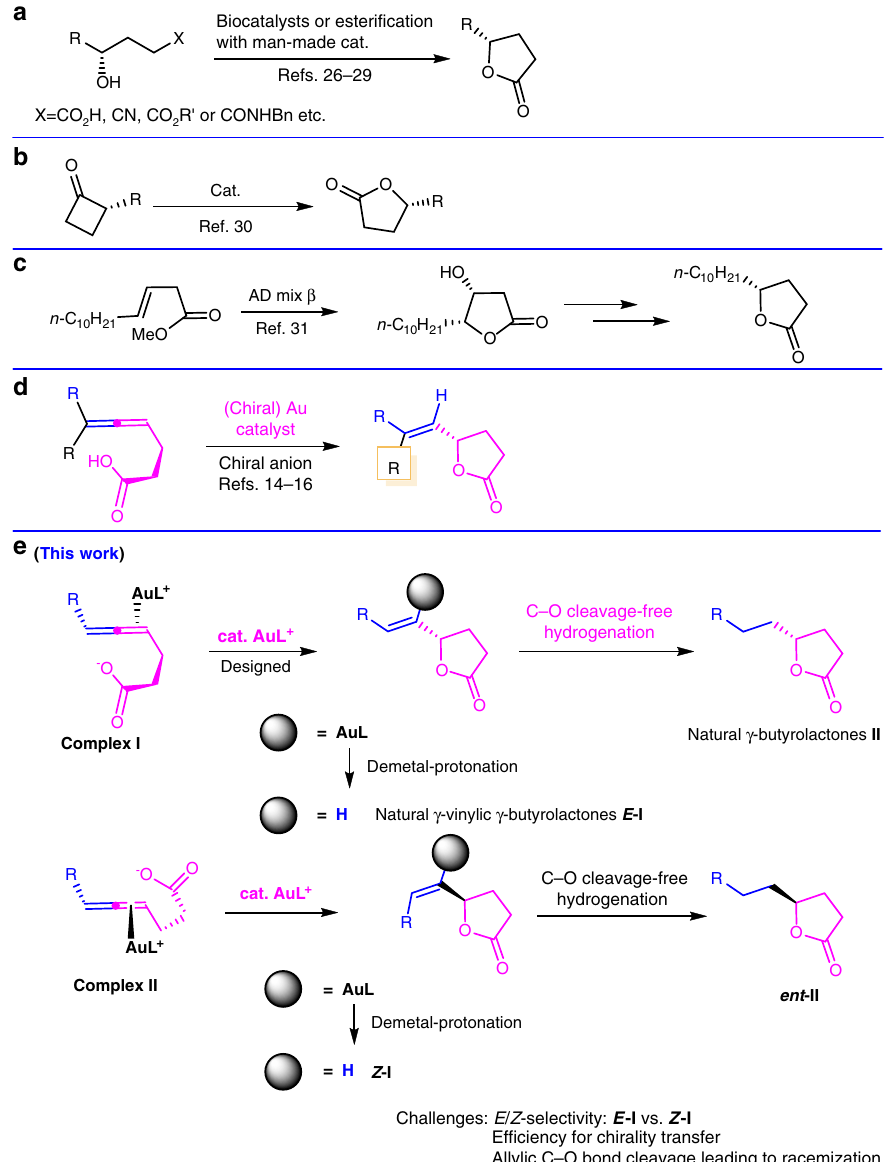
Fig. 2 Known approaches and the designed general protocol to γ -butyrolactones E - I and II . a Nature ’ s enzymatic approaches; b Baeyer – Villiger oxidation; c Alkenoate dihydroxylation; d Allene enantioselective approach described in refs. 14 – 16 . e Au-catalyzed chirality transfer-based asymmetric cyclization of allenoic acids (this